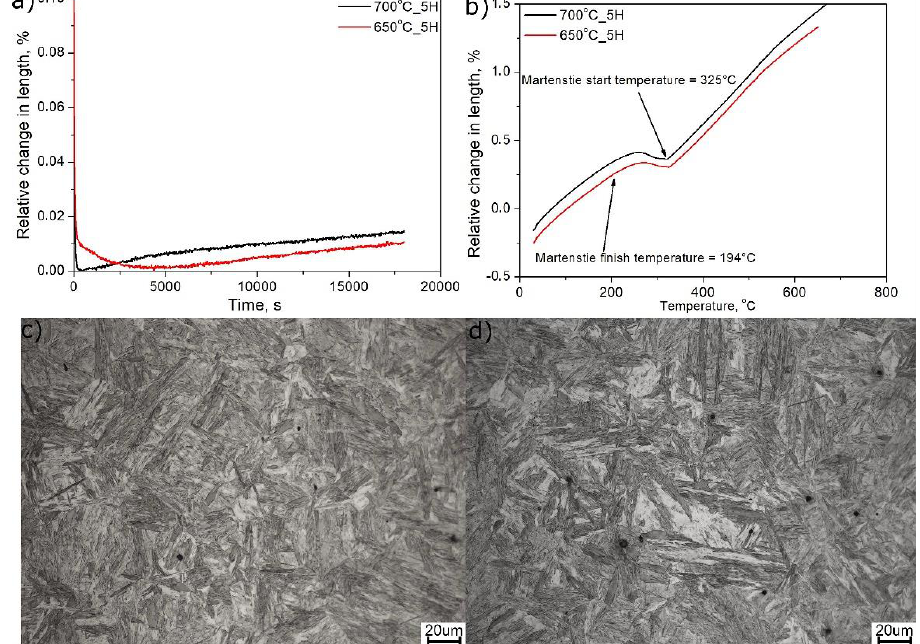
Figure 6. Results of dilatometry and microstructure investigation of simulated coiling process: ( a ) isothermal step; ( b ) cooling to room temperature; ( c ) microstructure after cooling from 700 ◦ C; ( d ) microstructure after cooling from 650 ◦